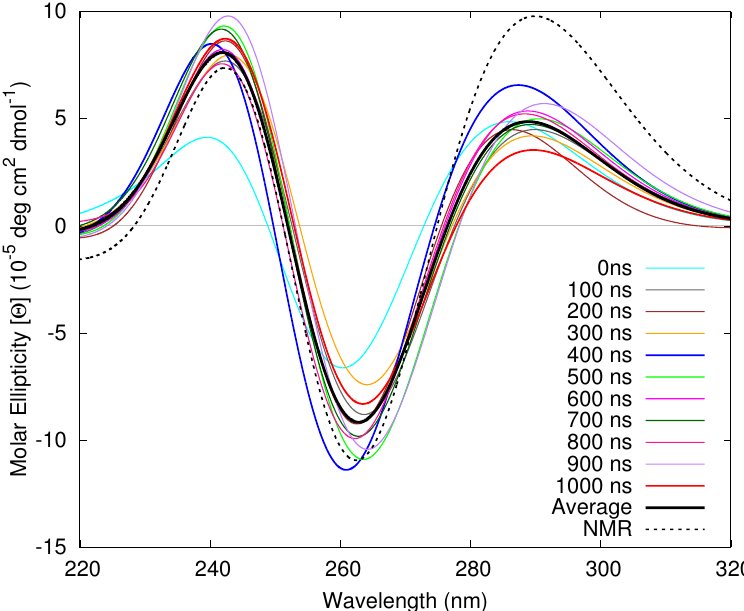
Figure 6. Computed ECD spectra of Tel21 GQ at the NMR structure and different time points on the MD Trajectory, as well as the average spectrum from the MD snapshots. All FrDEx calculations use strand as the SC to calculate H intra and pair as the SC to calculate H inter . All calculated spectra are shifted by − 0.85